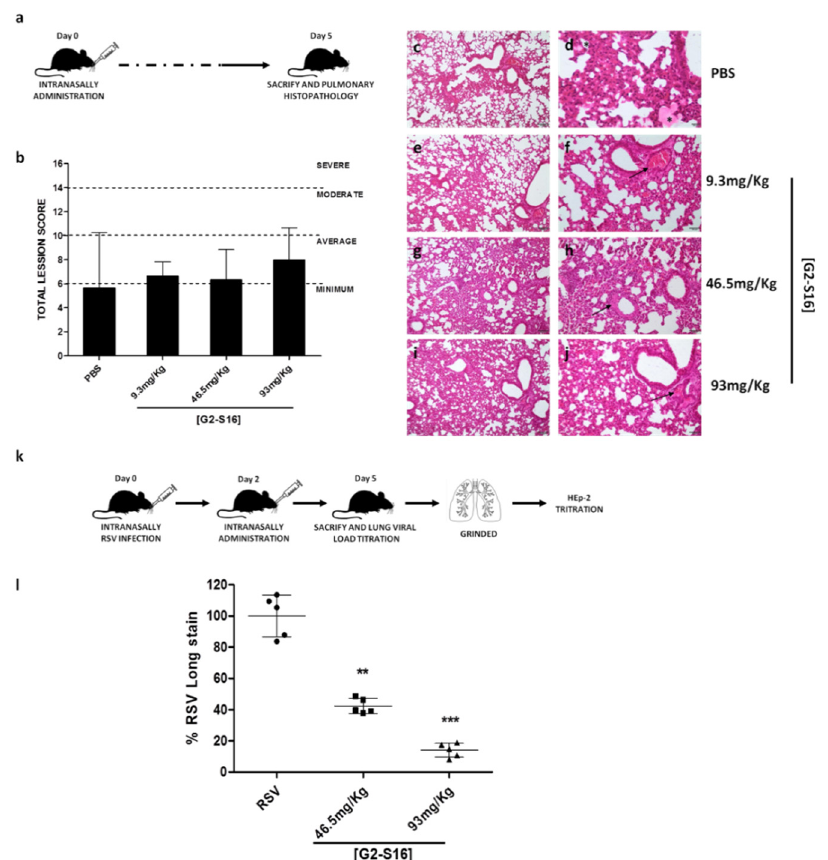
Figure 5. In vivo experiments with G2-S16 dendrimer. ( a ) Schematic representation of in vivo viability procedure. ( b ) Media of the accumulate score for each treatment group. ( c – j ) Histological studies of pulmonary damage. ( b – d ) Focal and minimal inflammatory infiltrate and atelectasis around the presence of an acellular and eosinophilic substance (possibly PBS) (asterisk). ( e , f ) Alveolar congestion of medium severity mainly around bronchioles and vessels in both cases (arrows). ( g , h ) Thickening of the walls of the arterioles in the areas of inflammation (arrows). ( i , j ) More diffuse lesions in the lung parenchyma with congestion and alveolar atelectasis. Presence of thrombi in vessels (arrow). ( k ) Schematic representation of in vivo antiviral activity procedure. ( l ) Percentages of inhibition of G2-S16 dendrimer corresponding to RSV infection of BALB/c mice and subsequent titer of the lung infection HEp-2 cells for 5 days. The figure represents the relative mean of five mice per group. RSV: BALB/c mice RSV infected and treated with PBS. **: p < 0.01; ***: p <